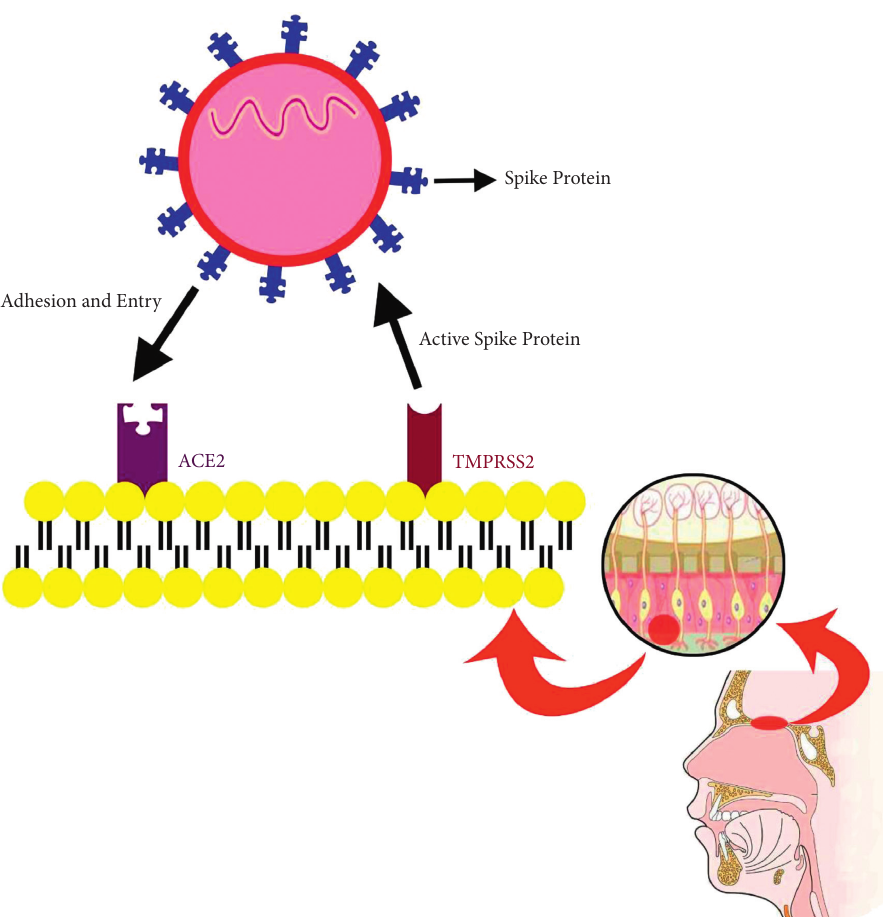
Figure 1: The probable mechanism of SARS-CoV-2 entry into the nasal cavity. TMPRSS2 and ACE2 are receptors existing on the surface of olfactory nonneural epithelium cells. TMPRRS2 activates the spike protein by cleaving viral S-glycoprotein. After that, the virus binds to the ACE2 receptor, and through this way, it can gain entry into human